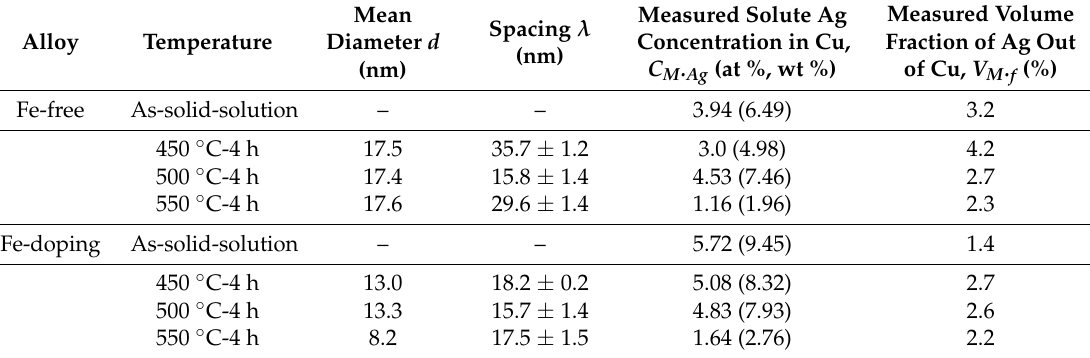
Table 1. Microstructural characterization of Fe-free and Fe-doping alloys at various temperatures.